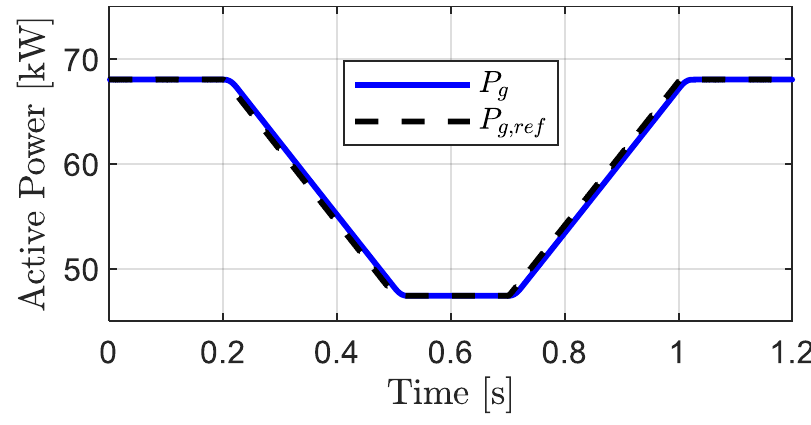
Figure 6. Active power to the grid time profile.